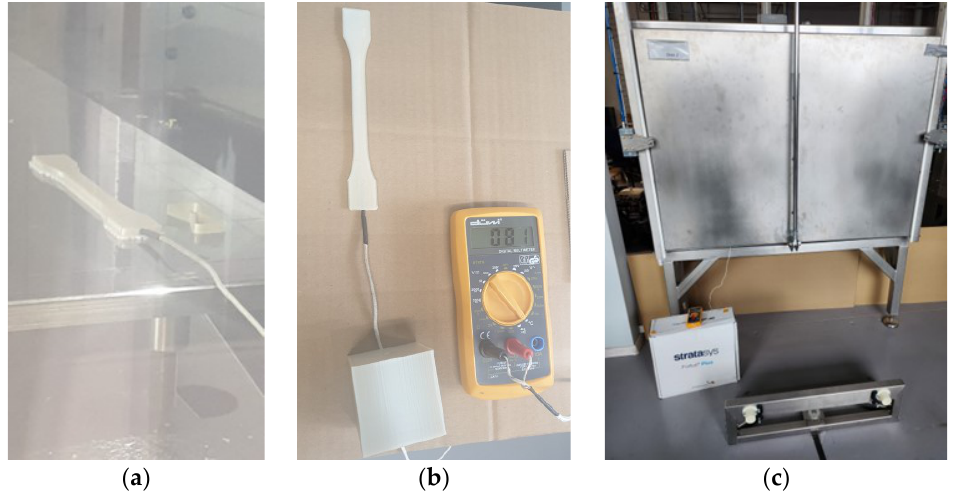
Figure 2. Ultem samples during post-printing cooling process in Stratasys F900 printer ( a ), at room temperature conditions ( b ), and in fully automatized oven with the sample inside it ( c ).